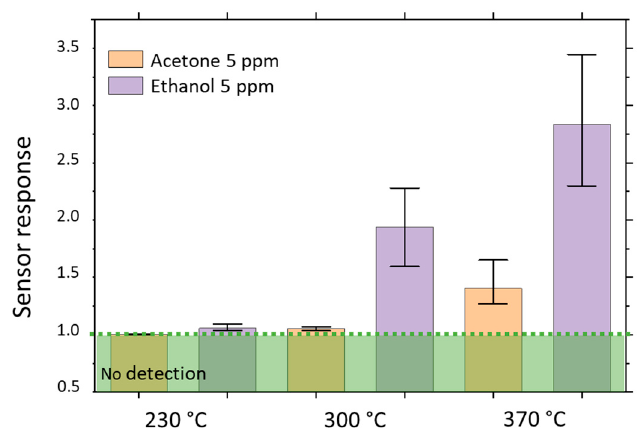
Figure 7. D Low devices response calculated at 230 °C, 300 °C and 370 °C to 5 ppm of acetone and 5 ppm of ethanol under 50% RH humid atmosphere. The top of the columns represents the mean response calculated from 4 devices and the upper and lower lines represent respectively the higher and lower value of sensor response obtained. Sensor response values were calculated from the third cycle of exposure at 230 °C and 300 °C and the sixth one at 370 °C.